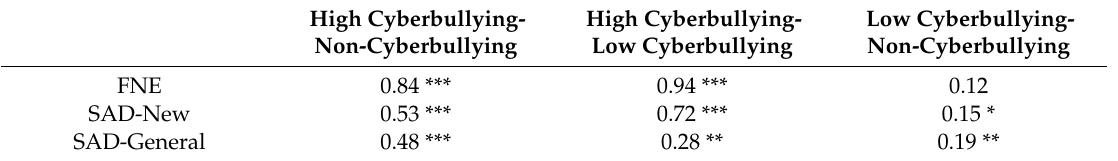
Table 4. Cohen’s d index to post hoc Bonferroni contrast between the means scores and the three classes in the factors of social